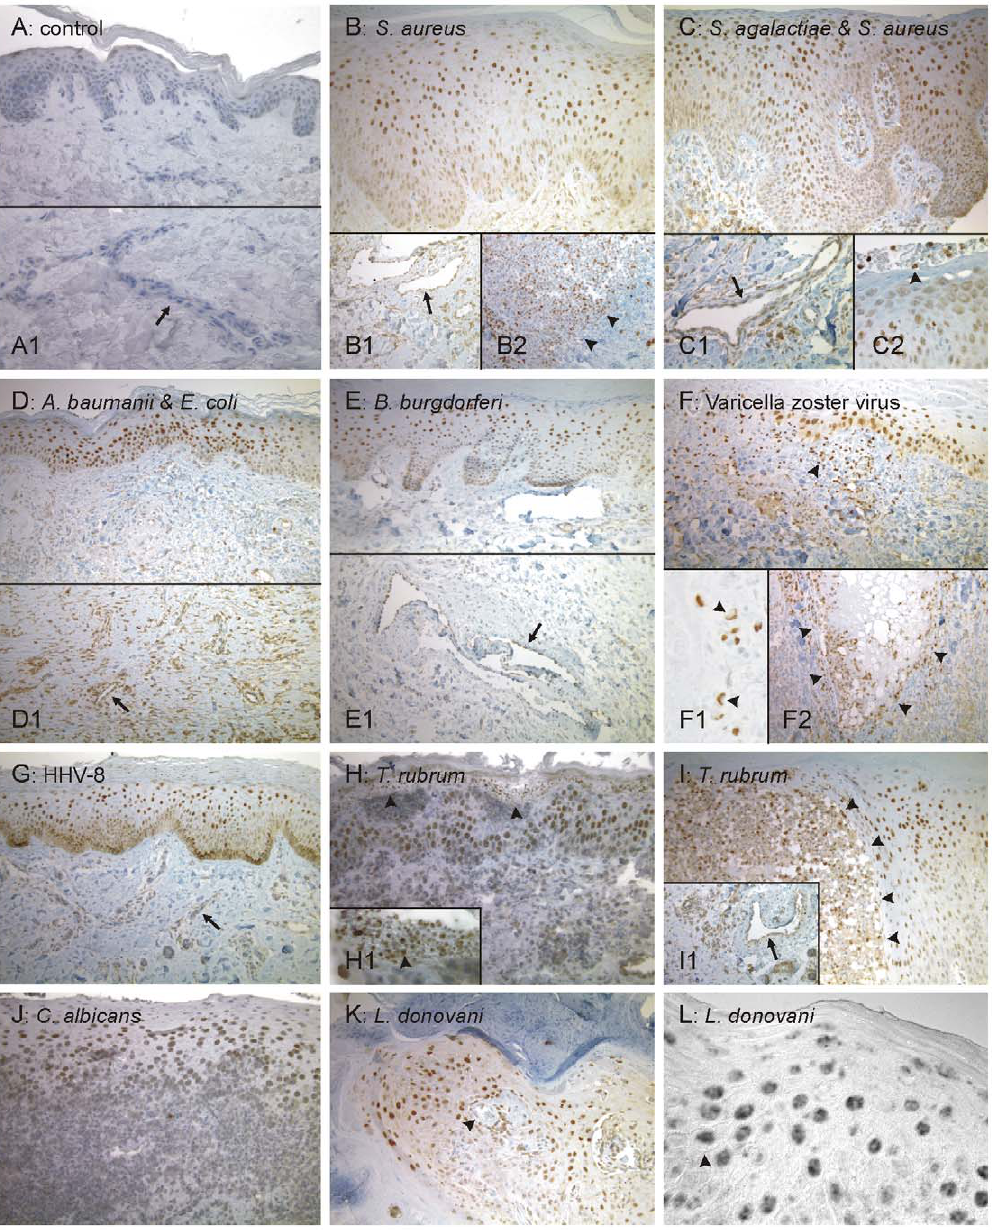
Figure 1. Detection of HIF-1 activation in human skin biopsies of patients suffering from cutaneous infections by immunohistochemistry. (A) In uninfected skin, rare and faint nuclear HIF-1 a staining occurred in the epidermis whereas the dermis was negative for HIF-1 a (A1). (B to L) In all cutaneous infections, a strong nuclear HIF-1 a signal was detected in keratinocytes, predominantly of the spinal cell layer (examplified in L). Moreover, endothelial cells of dermal capillaries frequently stained positive (arrows in B1, C1, D1, E1, G, I1). Arrowheads: (B2) border zone of the positive abscess; (C2): positive neutrophils; (F): positive dermal lympho-histiocytic infiltrates; (F1): large positive nuclei of a multi-nuclear giant cell; (F2): skin lesion surrounded by a HIF-1 positive inflammatory infiltrate; (H): positive sub-corneal neutrophils (higher power in H1); (I): positive intra-epidermal infiltrate; (K): intradermal nodules containing leishmaniae. (A) Control: uninfected sample; (B–E): bioptic samples of patients suffering from infections with humanpathogenic bacteria [(B) S. aureus , (C) S. agalactiae and S. aureus , (D) A. baumanii and E. coli and (E) B. burgdorferi ], (F, G) with humanpathogenic Herpes-viruses [(F) Varicella zoster virus (VZV) and (G) Human Herpes Virus-8 (HHV 8)], (H–J) with humanpathogenic fungi [(H + I) T. rubrum and (J) C. albicans ] or (K, L) with the protozoic pathogen L. donovani . Magnifications: all 250 6 , except for A1, B1, B2, C1, D1, E1, F2, I1 (all 400 6 ), and C2, F1, H1, L (all 1,000 6 ). doi:10.1371/journal.pone.0011576.g001 S. aureus 8325-4 and the S. aureus D hemB hemB- complemented strain but not when cells were infected with S. aureus D hemB . Here, a significantly increased oxygen consumption in cells infected with S.